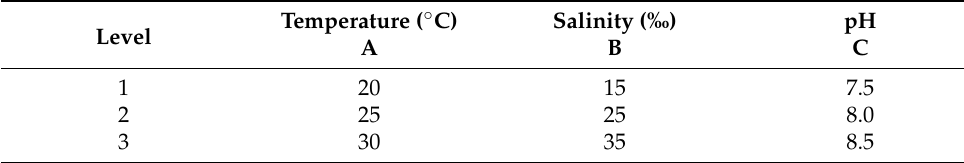
Table 1. Test factor levels.